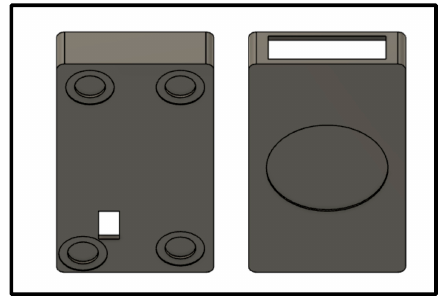
Figure 14. Cutouts for mounting and sensor accessibility.